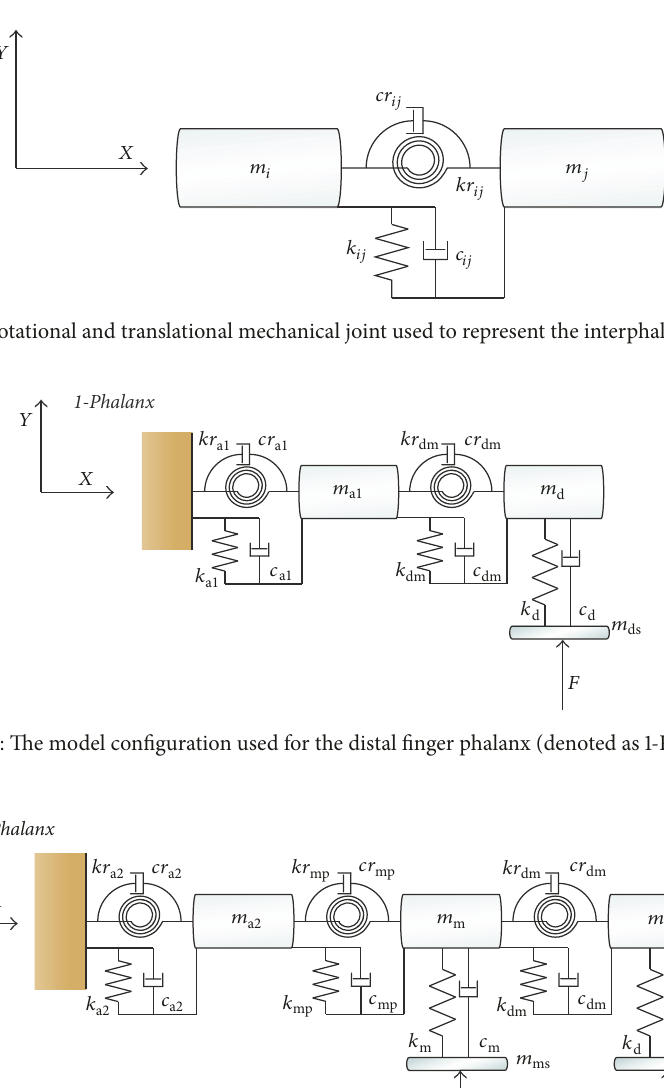
stiffness and damping are neglected due to the assumption of small rotations and also the negligible movement of the models in the 𝑋